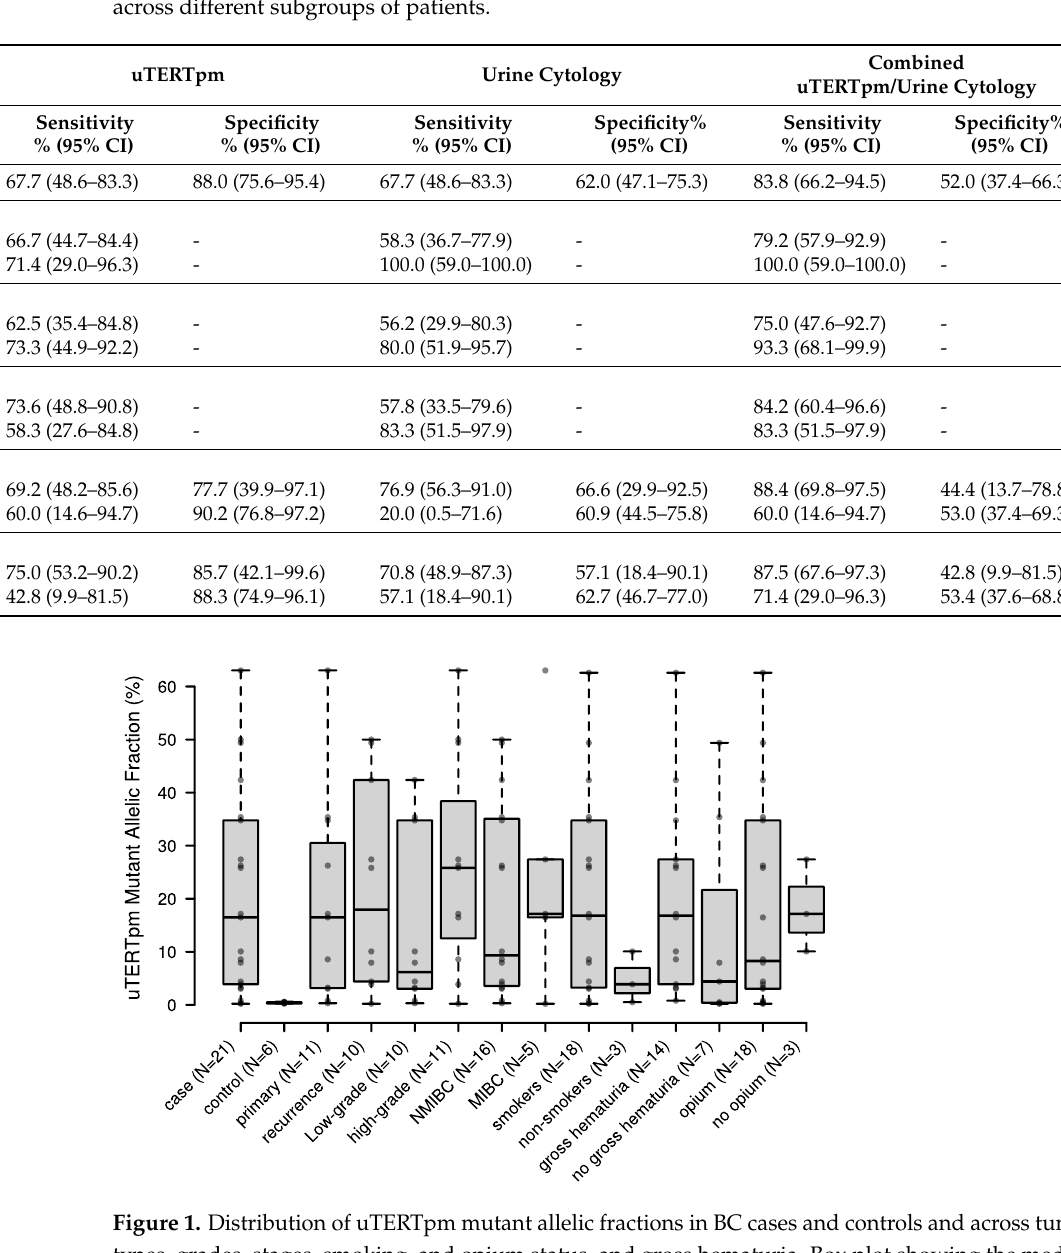
Figure 1. Distribution of uTERTpm mutant allelic fractions in BC cases and controls and across tumor types, grades, stages, smoking, and opium status, and gross hematuria. Box plot showing the median (solid lines), data points (circles), the 1st and the 3rd quartiles of mutant allelic fractions. The upper and lower Tukey whiskers are shown (dashed lines), i.e., whiskers extend to data points that are less than 1.5 × Interquartile range away from 1st/3rd quartile. NMIBC: non-muscle-invasive bladder cancer; MIBC: muscle-invasive bladder cancer .